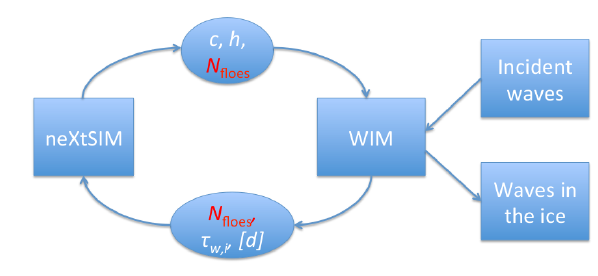
Figure 3. Schematic showing the information that passed between neXtSIM and the WIM. Note that N floes is modified by both the WIM and neXtSIM (which use different grids), so must be treated carefully to avoid numerical diffusion. Also input to the WIM are incident wave fields, and it also outputs diagnostic fields of the waves in the ice. The WIM may also update the damage d